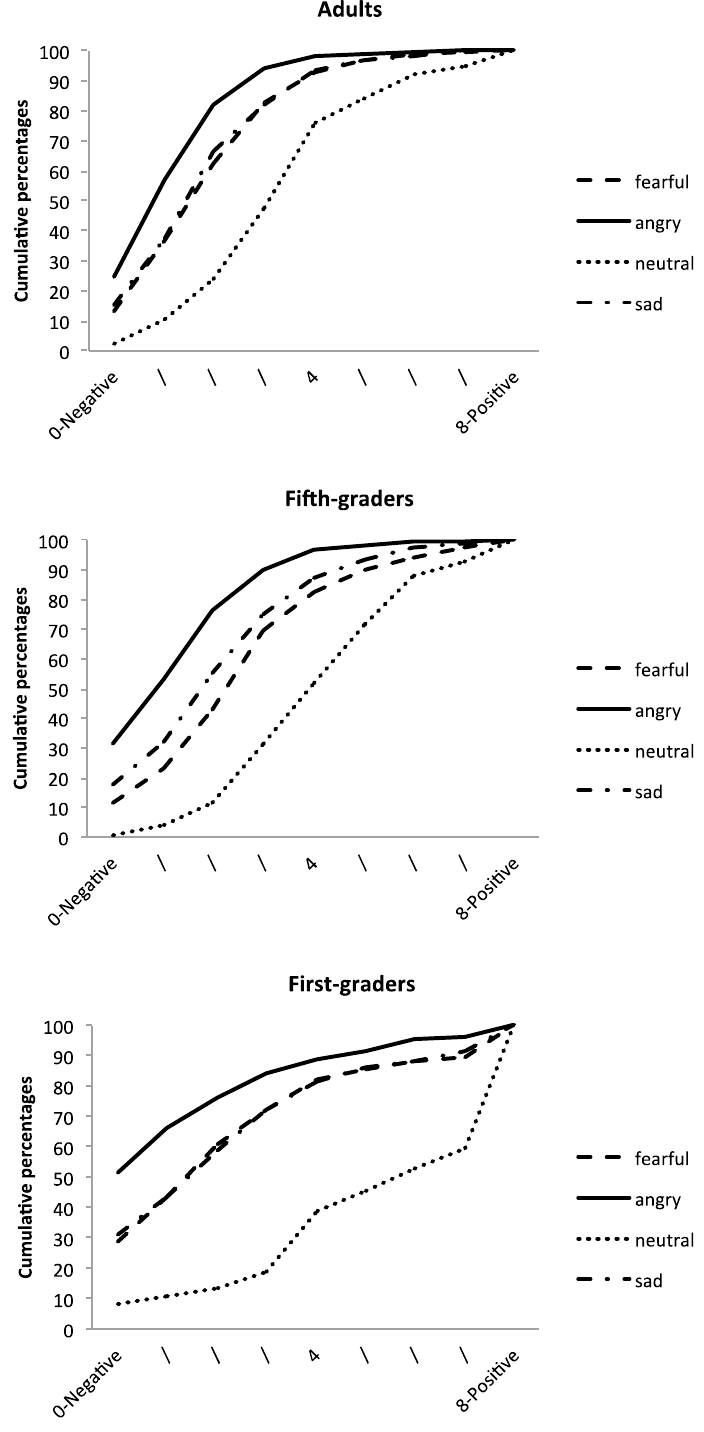
Figure 8. Cumulative percentages of the perception of EFE on Scale 4, for each age